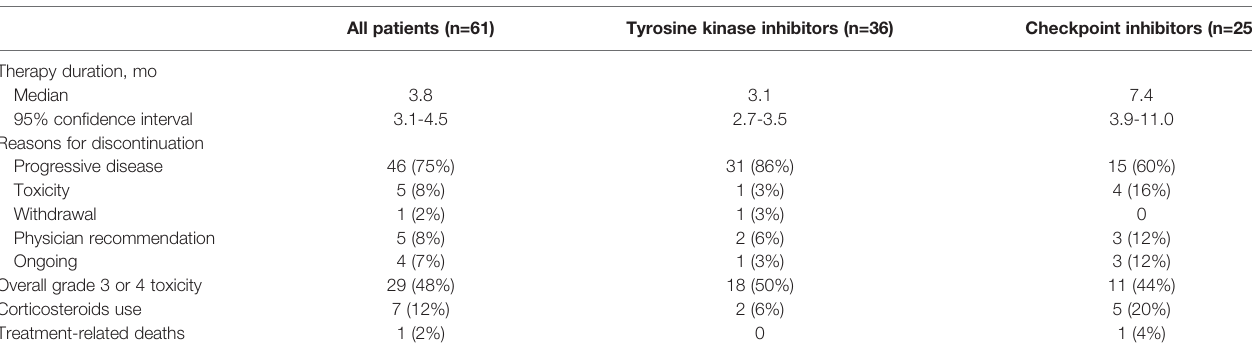
TABLE 2 | Therapy compliance and